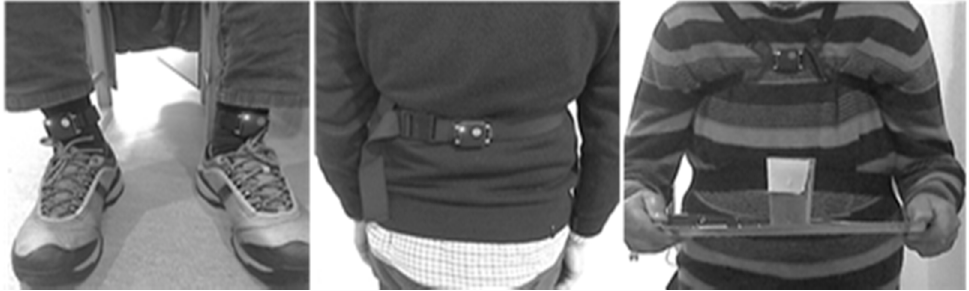
Figure 1. Placement of the Opal sensors and tray with a glass of